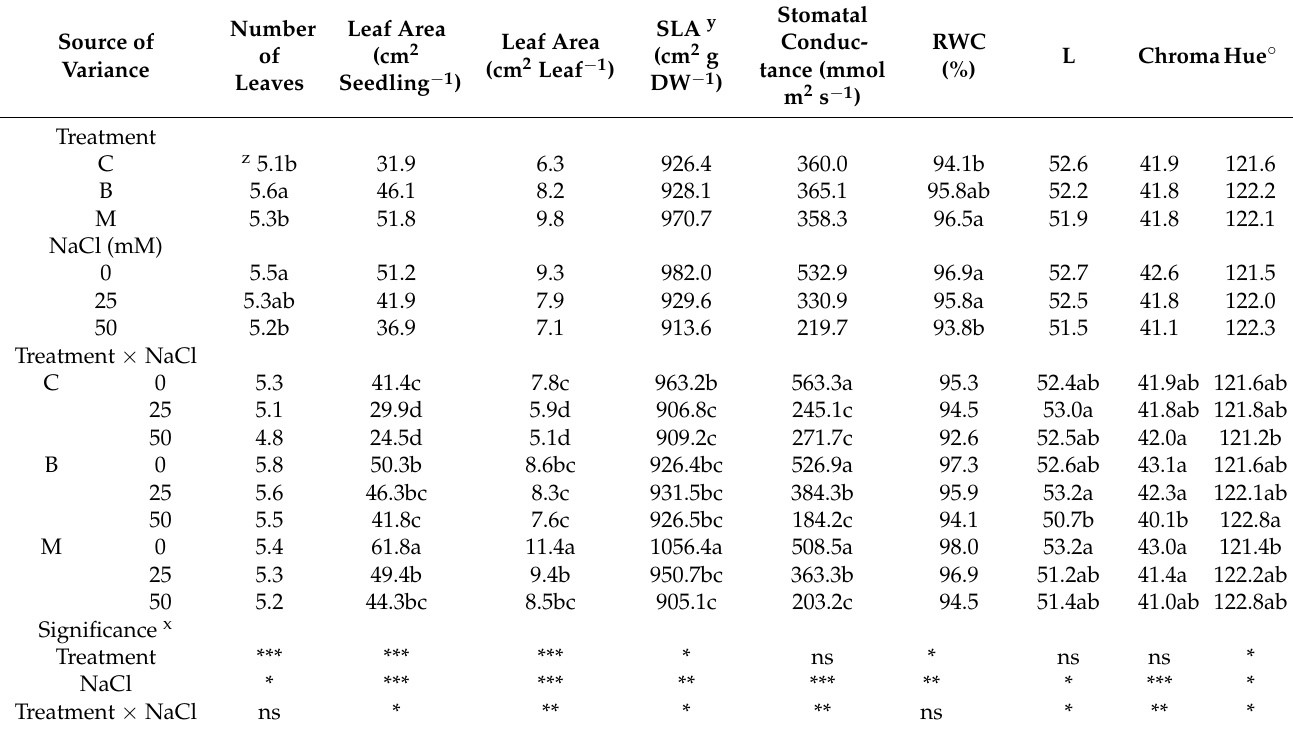
z Each value is the mean of four replicated samples of 30 seedlings each. For each factor, values in a column followed by the same letter are not significantly different, according to the LSD test. x Significance: ns = not significant; * significant at p < 0.05; ** significant at p < 0.01; *** significant at p < 0.001; y Specific leaf